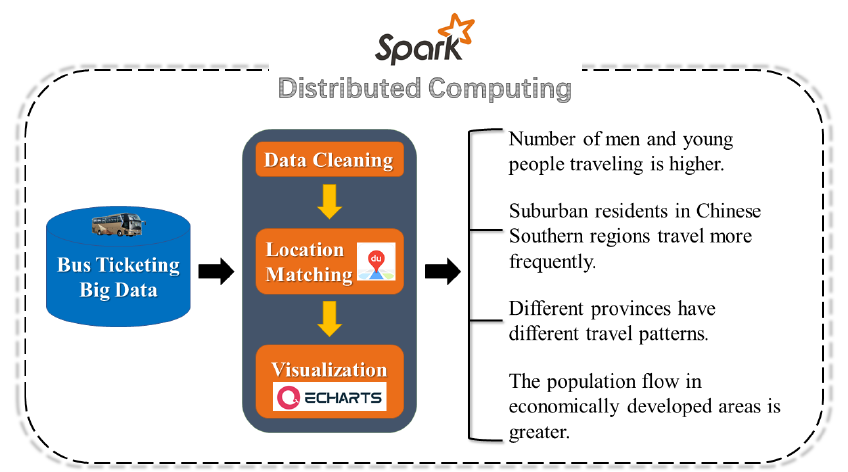
Figure 5. The Research Framework. The calculation framework, processing flow and main results are